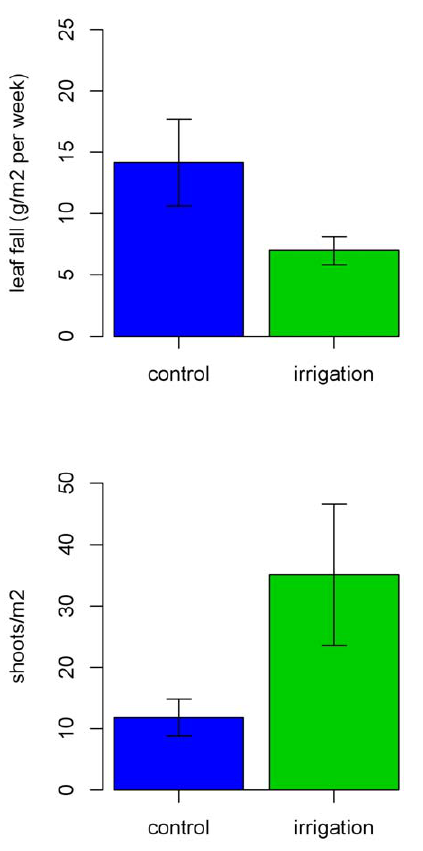
Figure 4. Variation in weekly leaf fall and ground level shoot growth after irrigation on control and treatment plots at Font Hill, Jamaica (values include mean and 95% confidence